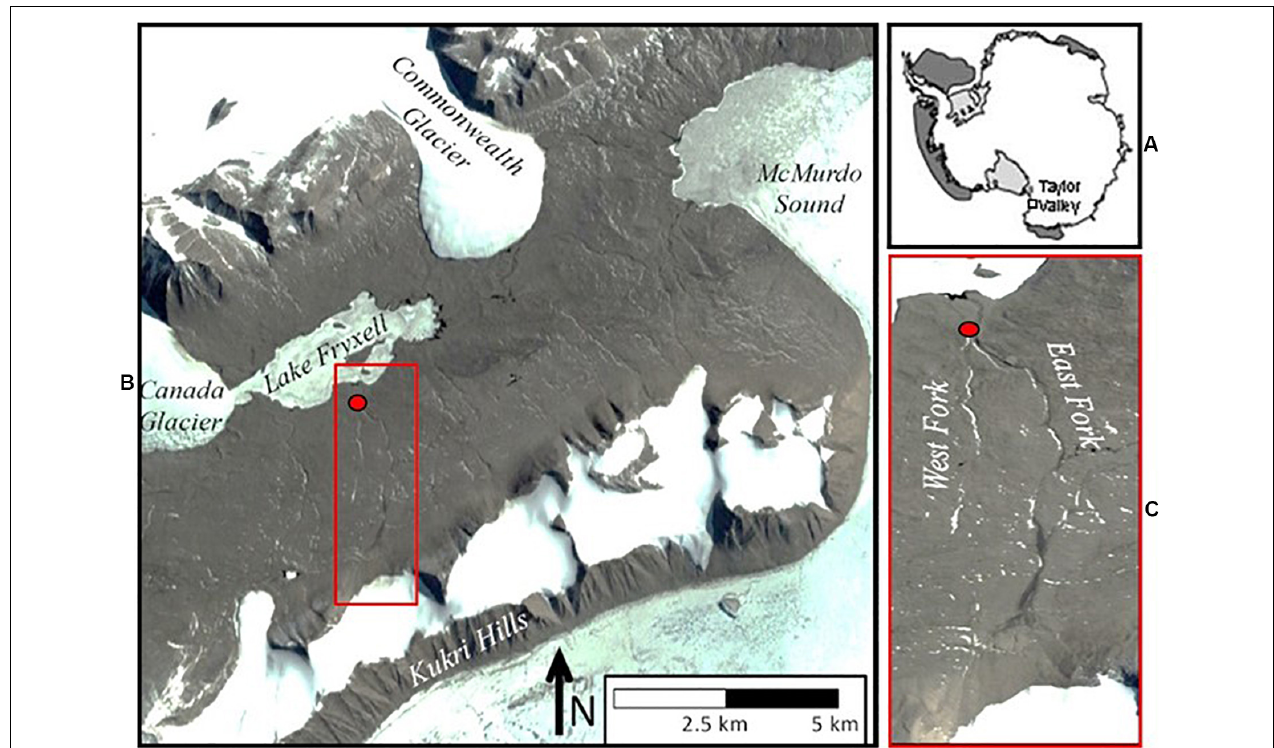
FIGURE 1 | Crescent Stream is located in Taylor Valley in the Lake Fryxell basin, McMurdo Dry Valleys (A) . Crescent Stream is supplied by glacial meltwaters in the Kukri Hills and drains into Lake Fryxell (B) . Samples were collected during the Austral summer in 2014–2017 at the F8 gauge (red circle), located 150 meters above the 1999 Lake Fryxell lake level (C) . Figure adapted from Gooseff et al. (2002,